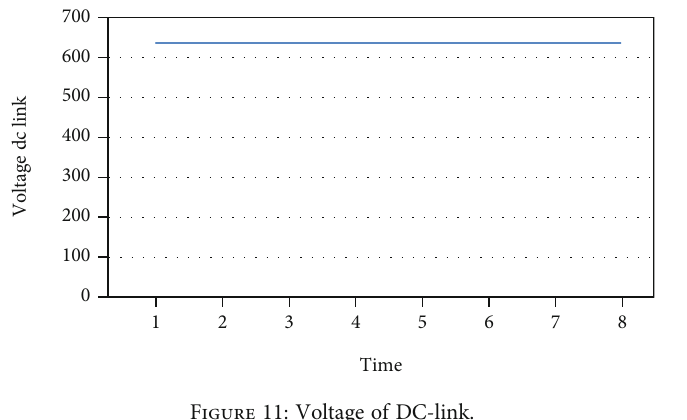
Figure 11: Voltage of